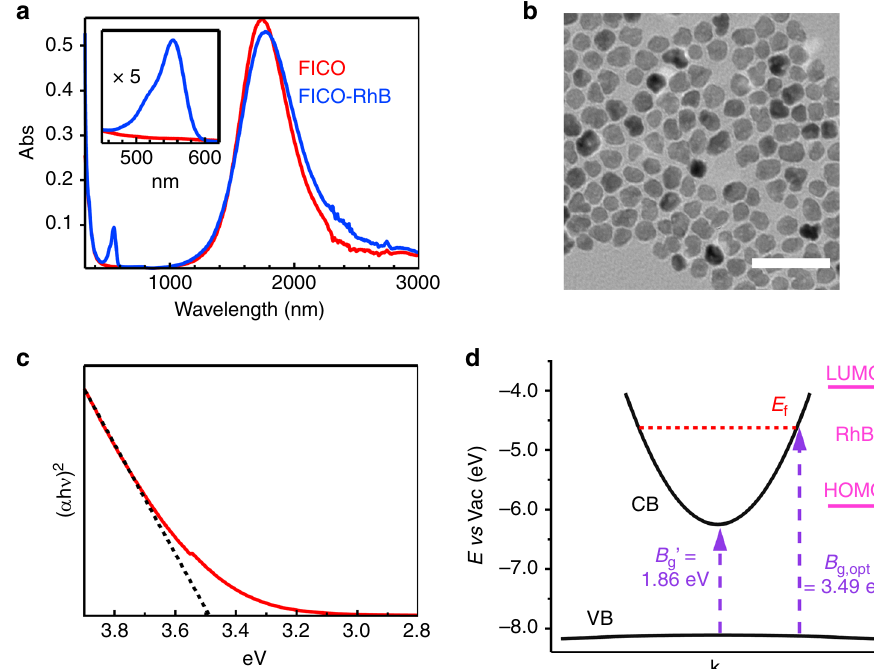
Fig. 1 Characterization of FICO nanocrystals. a Absorption of FICO nanocrystals (NCs) and FICO – Rhodamine B (RhB) complex. Insert shows the RhB absorption with vertical axis magni fi ed by 5 times (×5). b TEM image of FICO NCs. c Tauc plot (red line) of FICO NCs and its liner fi t (black dotted line) showing the optical bandgap of FICO at ~3.49 eV. d Band diagram of the FICO NCs and RhB. E f is Fermi level, B direct bandgap after band renormalization correction. The arrows show the optical transitions with energy of B 0